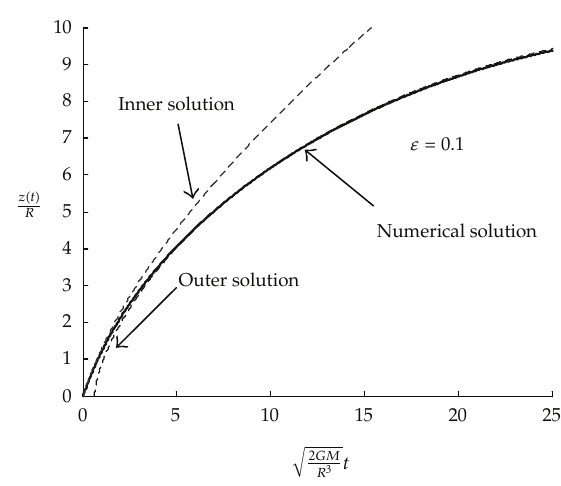
Figure 5: The function z (cid:4) t (cid:5) with ε (cid:7) 0 . 1. The solid line corresponds to numerical integration of (cid:4) 3.1 (cid:5) , the dashed line represents the outer solution and the inner